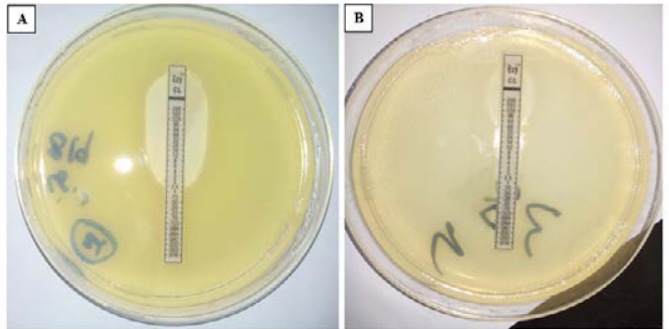
Fig. 1. Colistin susceptibility by E test. A: sensitive isolate (MIC = 1.5µ g/ml). B: resistant isolate (MIC = 64µ